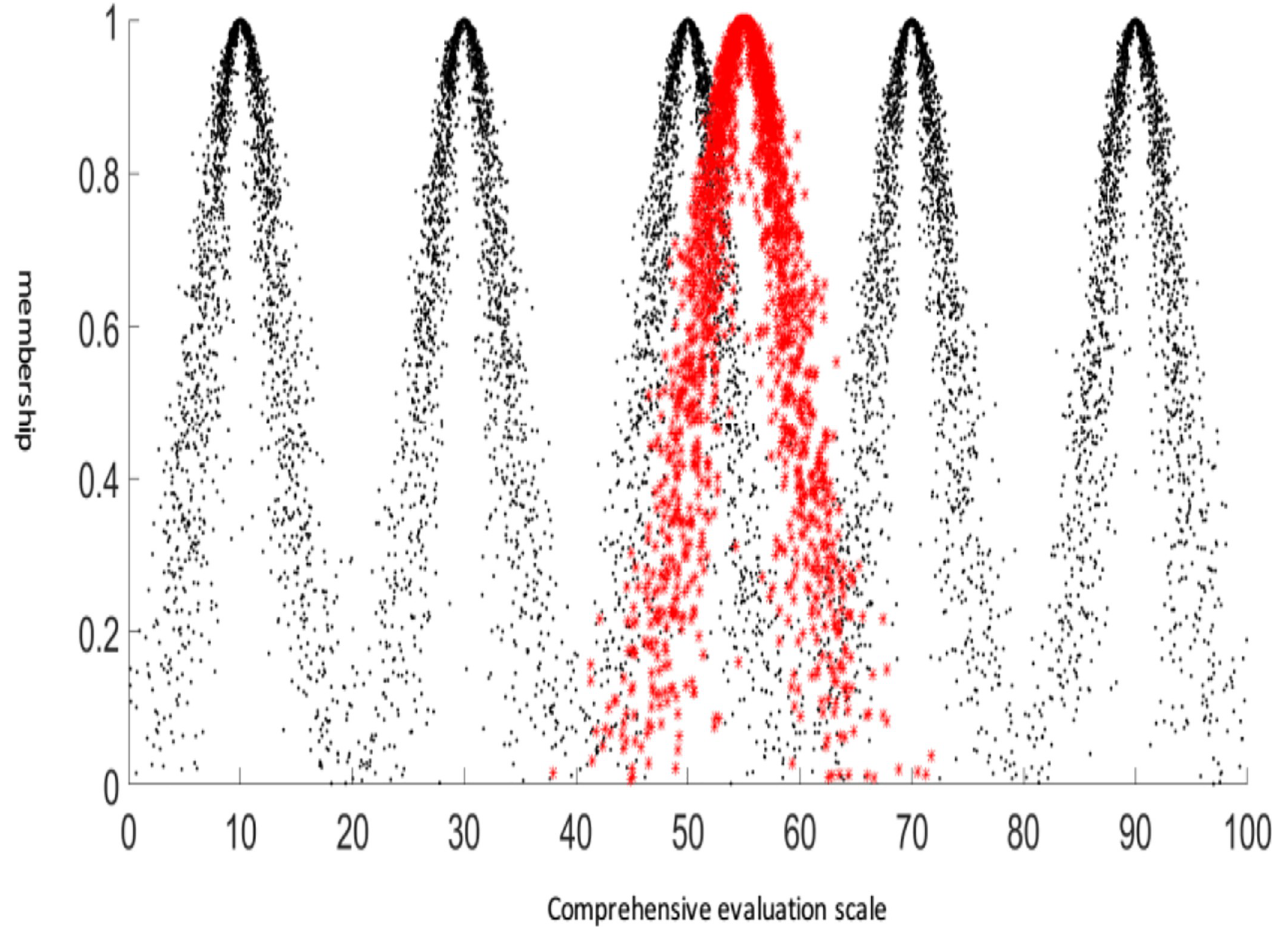
Fig 5. Comparison of the cloud model and the risk assessment cloud